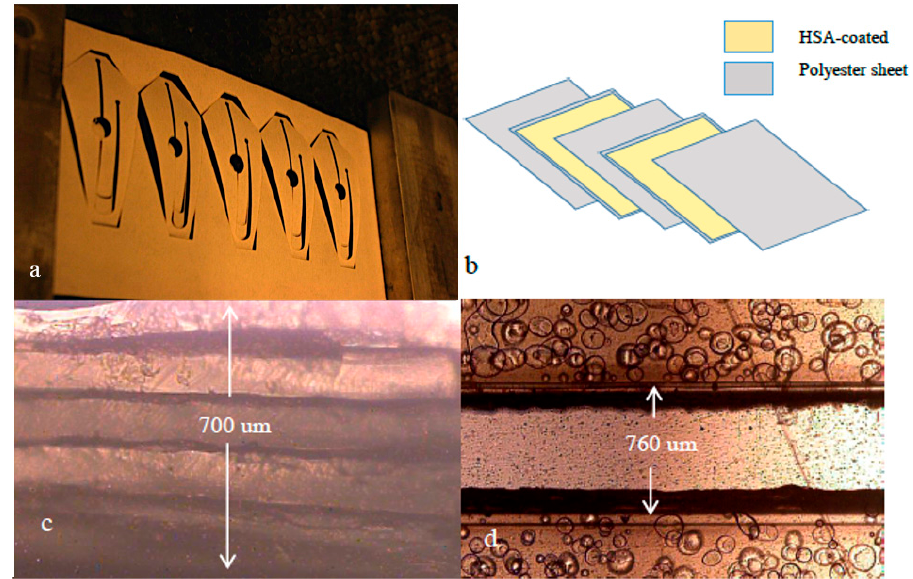
Figure 1. ( a ) Photograph of single layer of polyester transparency with heat-sensitive adhesive (HSA) and backing on each side, post-cut [8]; ( b ) Schematic describing the separate layers comprising the device. PeT (grey) and HSA (beige) layers; ( c ) Microscopic image of device cross section showing five layers; ( d ) Microscopic image of device channel.